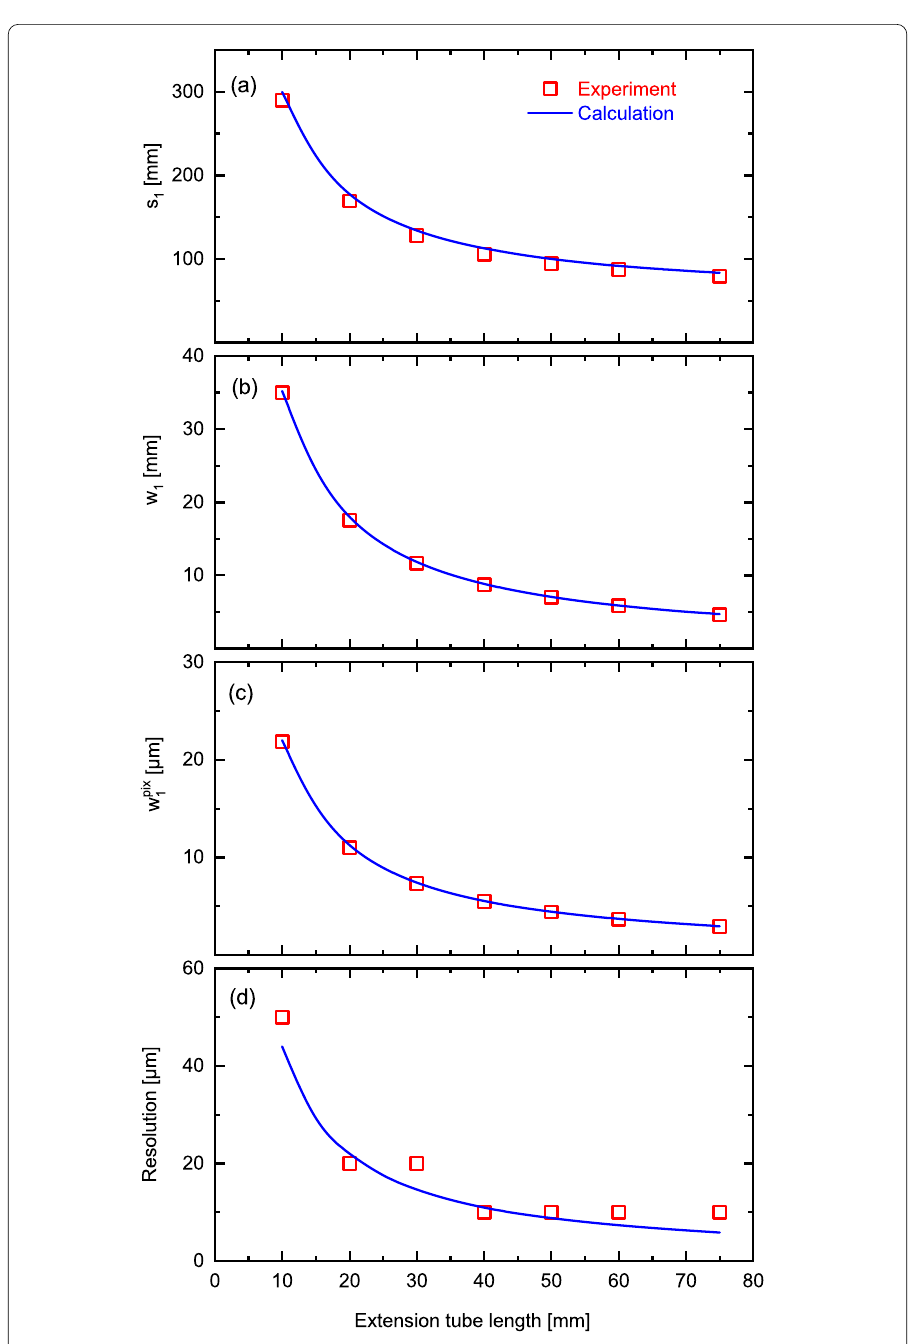
Figure 9 Experimental (red squares) and calculated (blue lines) performance parameters of a telemicroscope in dependence on the extension tube length: object distance ( a ), total horizontal field of view ( b ), horizontal field of view per pixel ( c ), and lateral resolution ( d ). (Sensor resolution: 1600 × 1200 pixels; sensor size: 7.04 mm × 5.28 mm; pixel size: 4.4 μ m × 4.4 μ m; focal length: f = 50 mm; f-number: N =